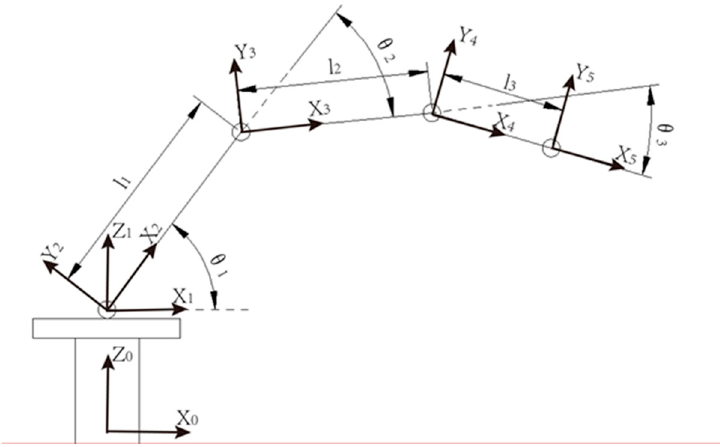
Figure 2. Denavit–Hartenberg (D–H) coordinate system of the mobile concrete pump manipulator.